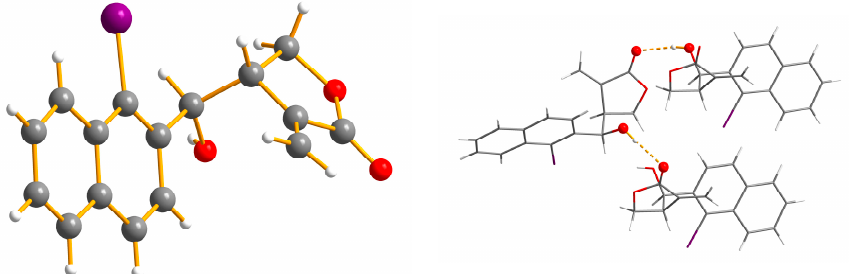
Figure 3. X-ray structure of 12 and diastereoselectivity [24].